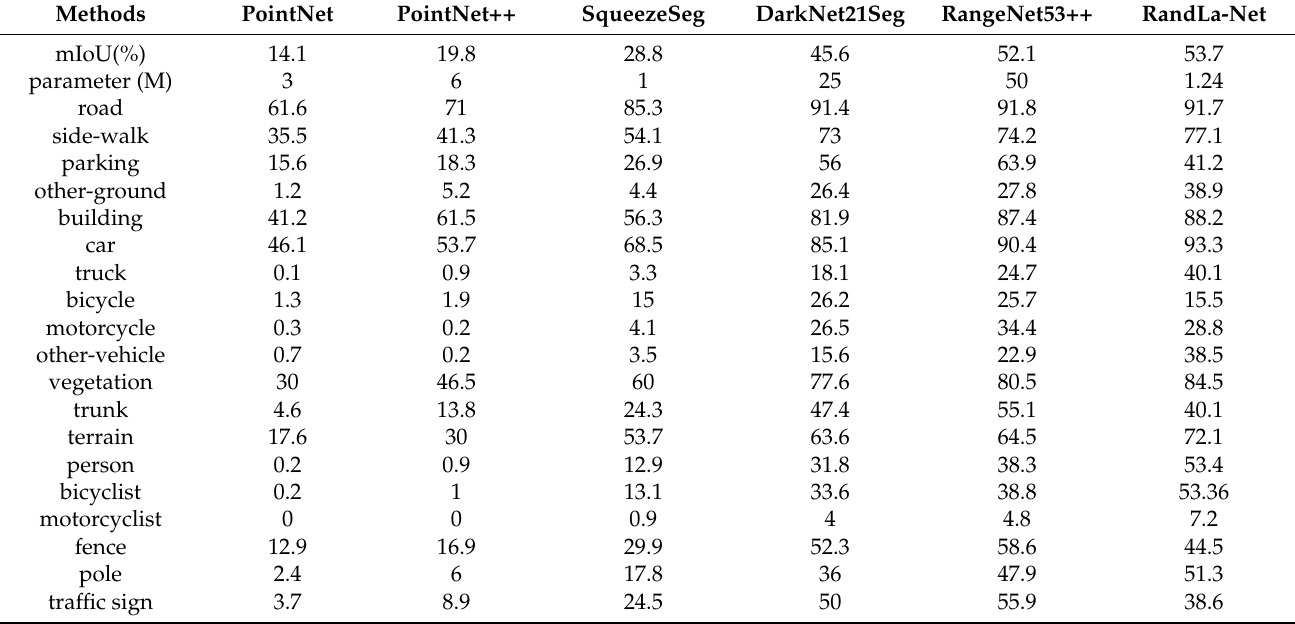
Table 1. Quantitative results of different approaches on semantickitti.